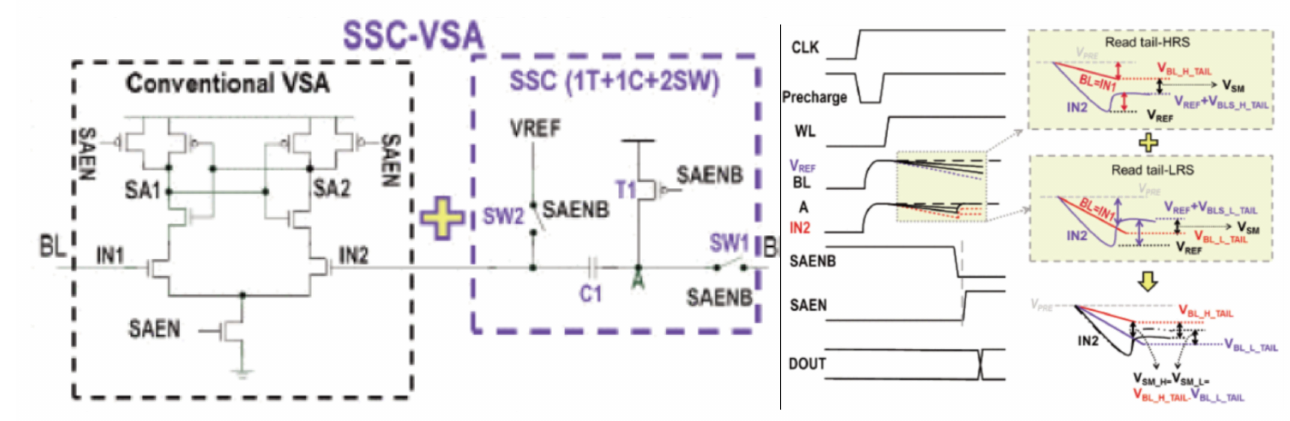
Figure 8. The structure and operation waveform of SSC-VSA [81].